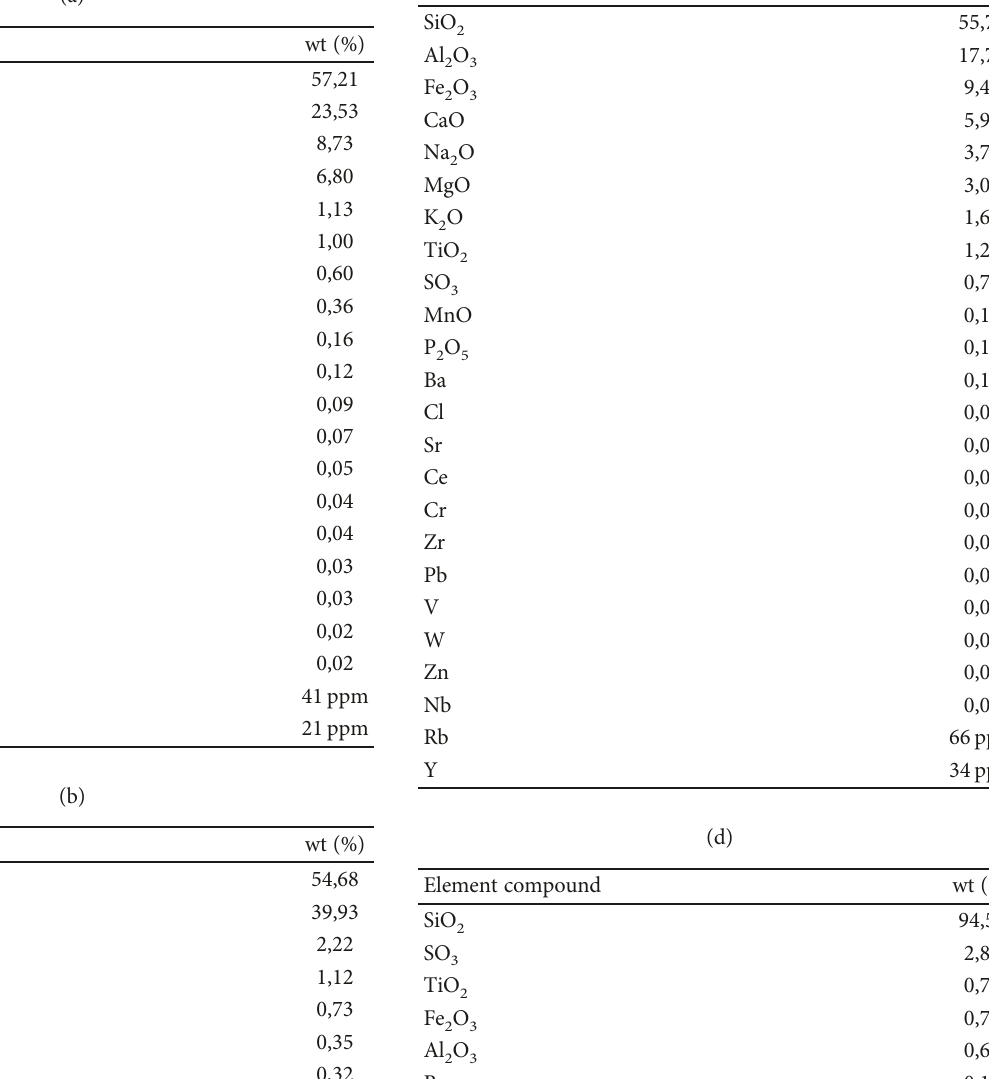
Table 6: XRF analysis of Coconuco samples: (a) CO2-A. (b) CO3-A. (c) CO11-A. and (d) CO13-A.